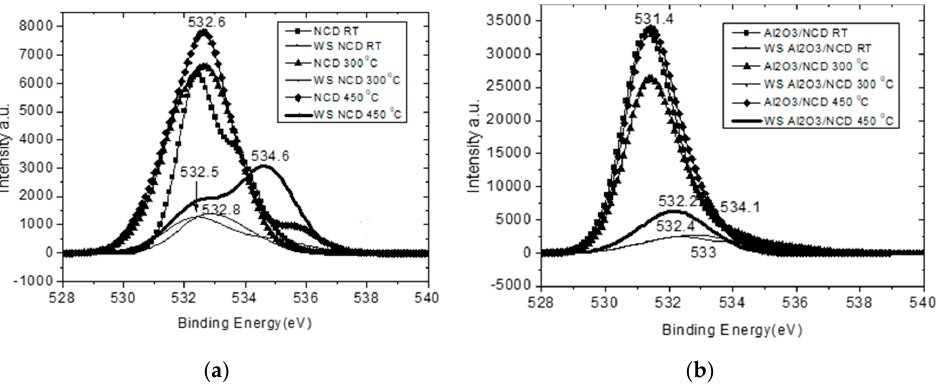
Figure 11. XPS spectra of the O 1s peak (WS-wear scar) taken on the ( a ) NCD and ( b ) Al 2 O 3 /NCD films.